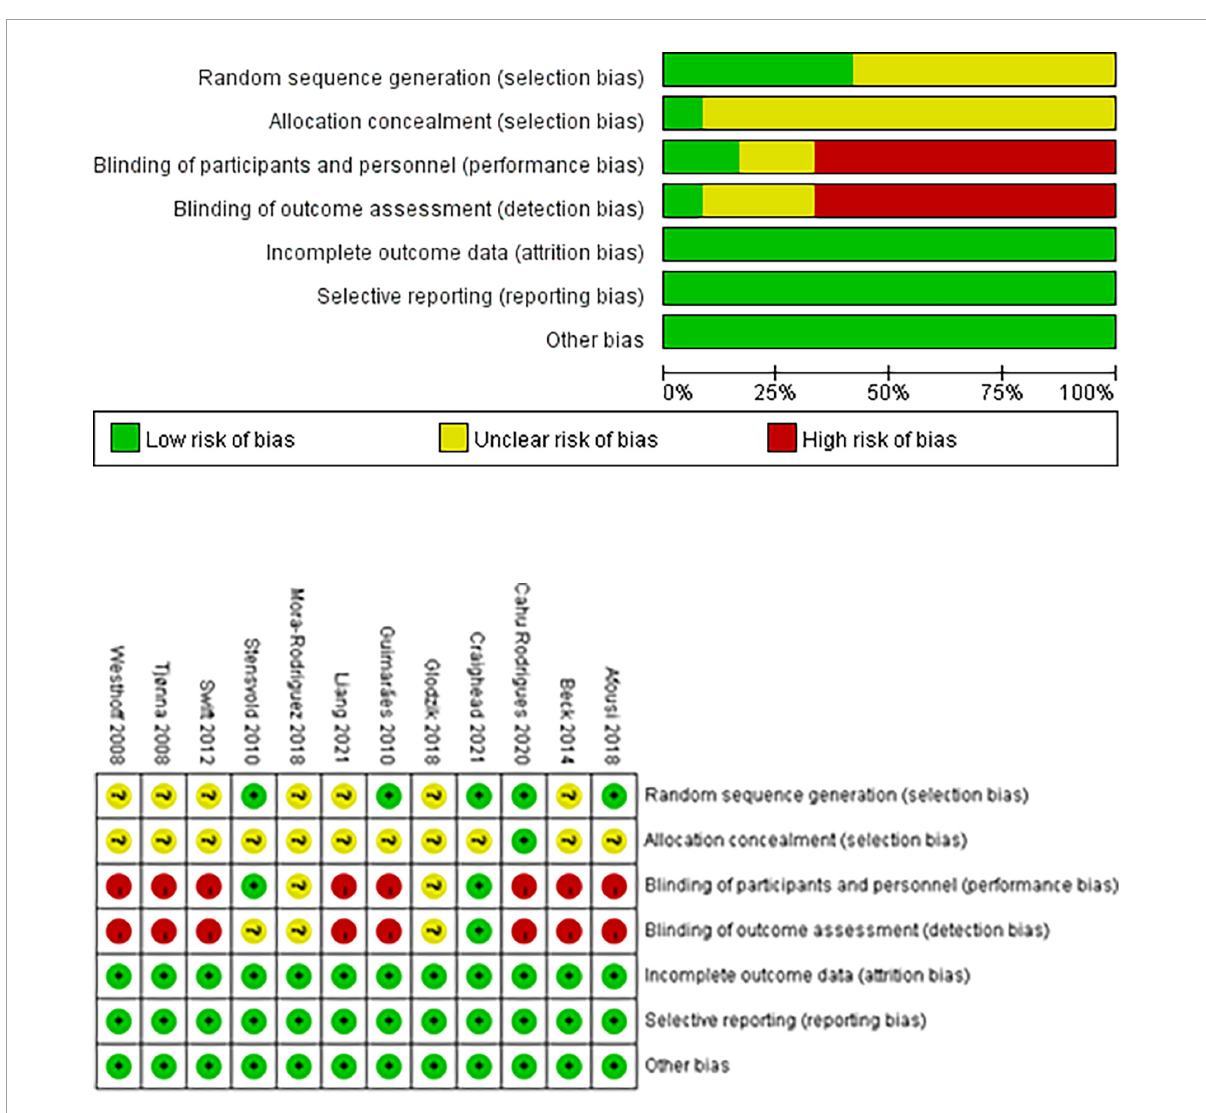
FIGURE2 Cochrane risk-of-bias evaluation